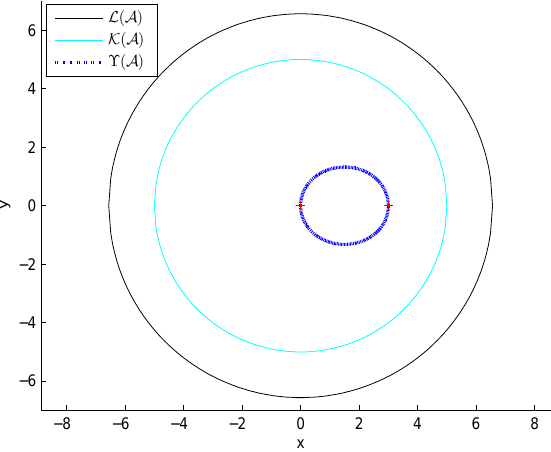
Figure 1. Comparisons of Z-eigenvalue inclusion